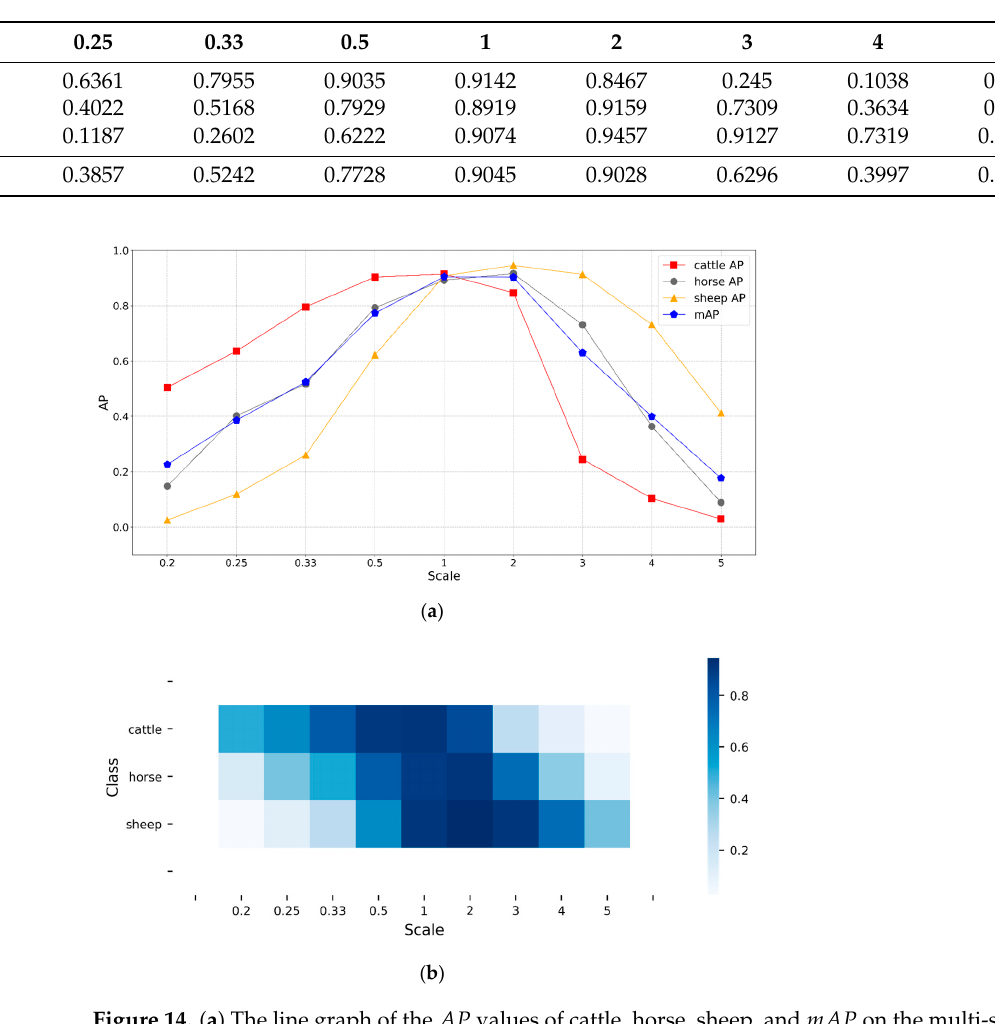
Table 9. AP of three animals’ detection at different scales.